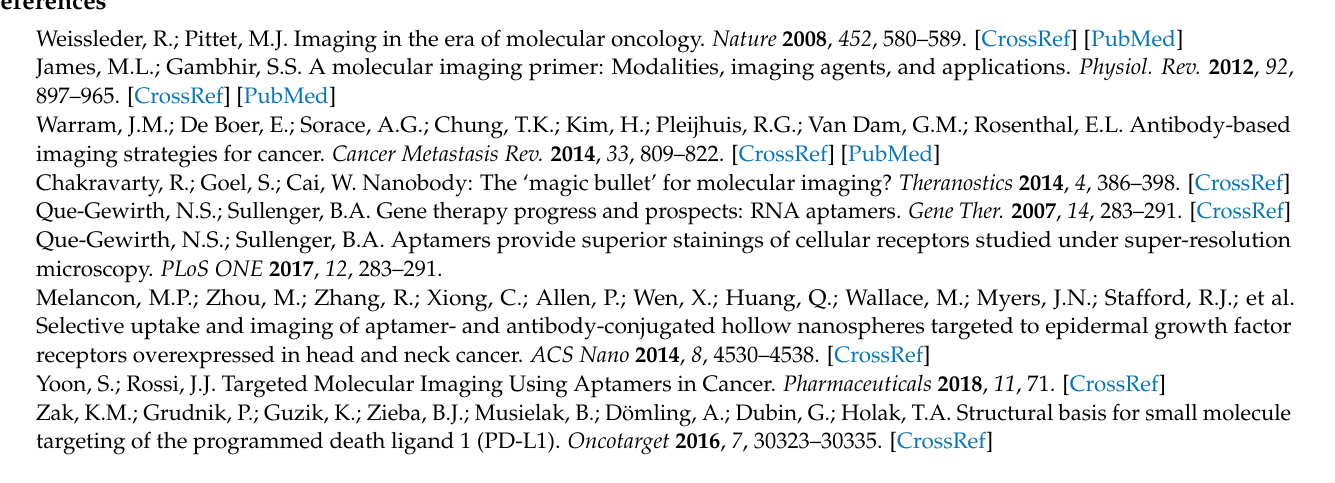
Figure S2: Total number of molecules (sequences) in the last three selection cycles in clusters c2, c3 and c4. Figure S3: Effect of 2c2s aptamer on inhibition of PD-L1 and PD-1 protein interaction in vitro. Figure S4: Model of a 2D structure of 2c2s aptamer. Figure S5: The kinetics of aAPC/CHO-K1 and PD-L1 aAPC/CHO-K1 tumor growth. Figure S6: The scheme of fluorescence imaging experiment with PD-L1 aAPC/CHO-K1 tumor bearing BALB/c nude